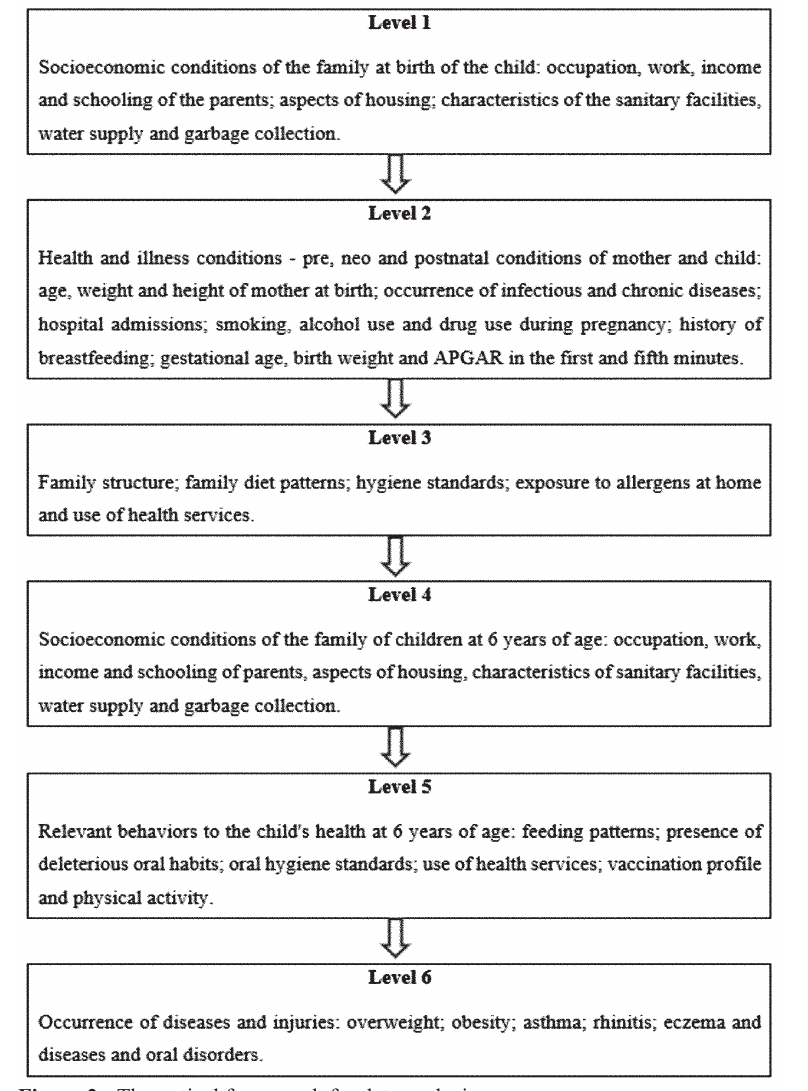
Figure 2 - Theoretical framework for data